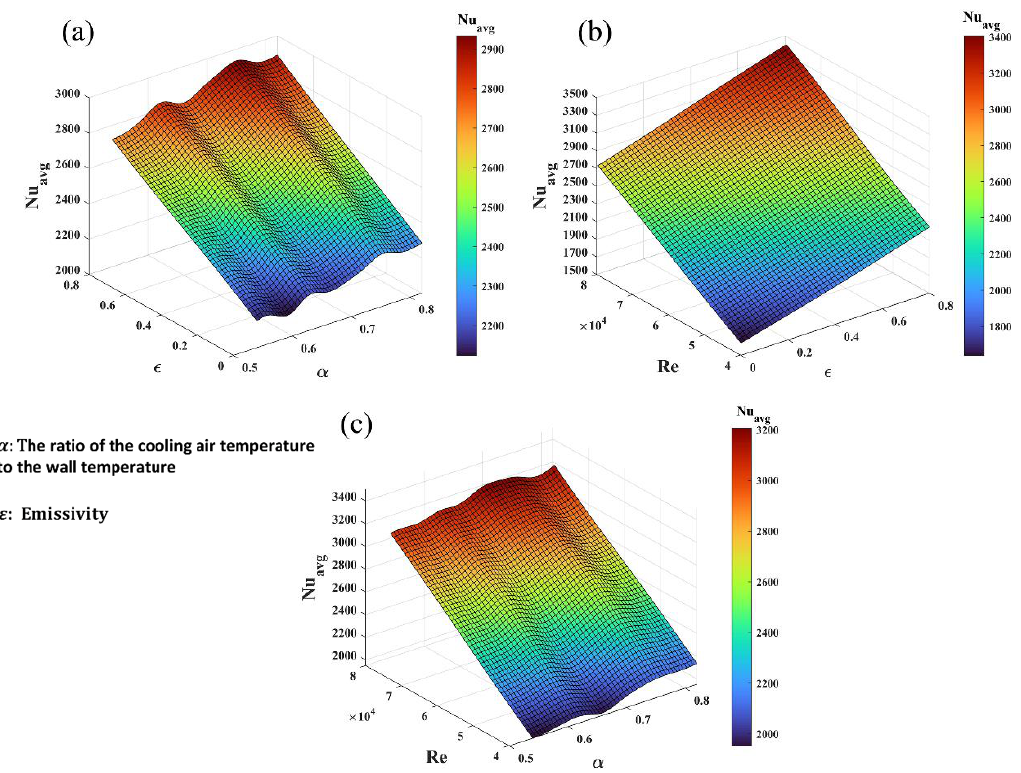
Figure 21. Influence of 𝛼 , 𝜀 , and Re on the average Nusselt number of the wall_l surface.